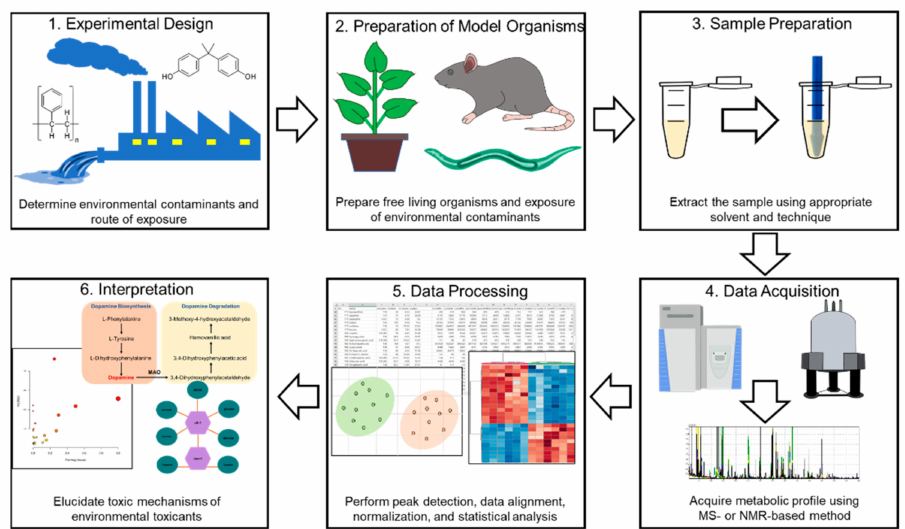
Figure 1. Representative workflow of environmental